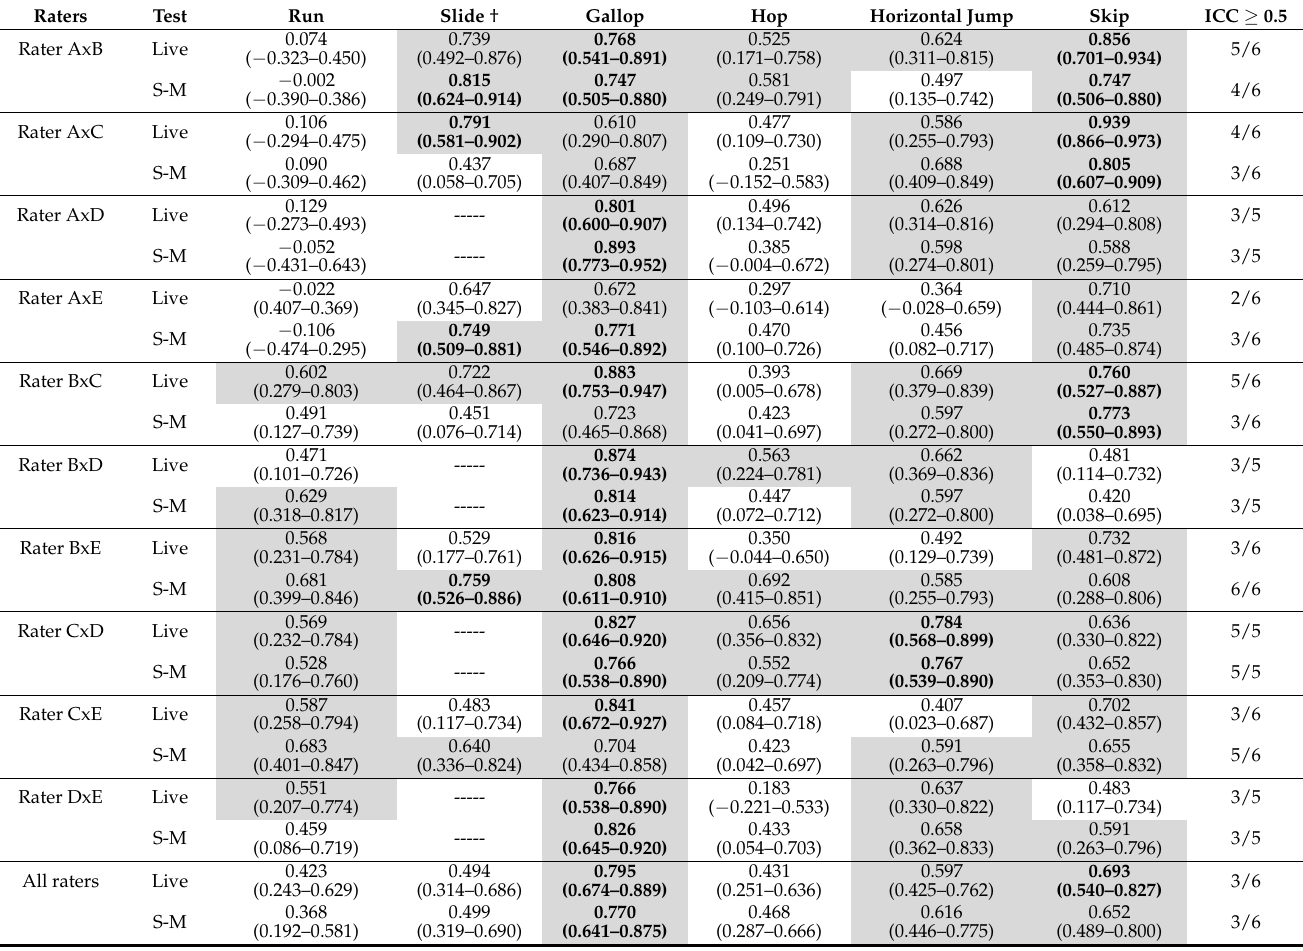
Table 3. Inter-rater reliability * among raters. Locomotor skills.